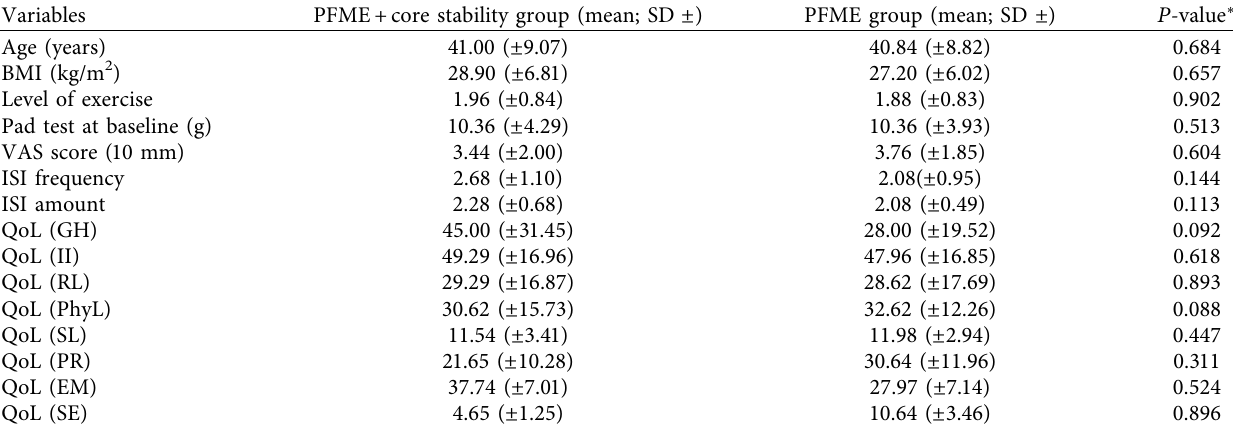
Table 1: Baseline characteristics of the respondents.